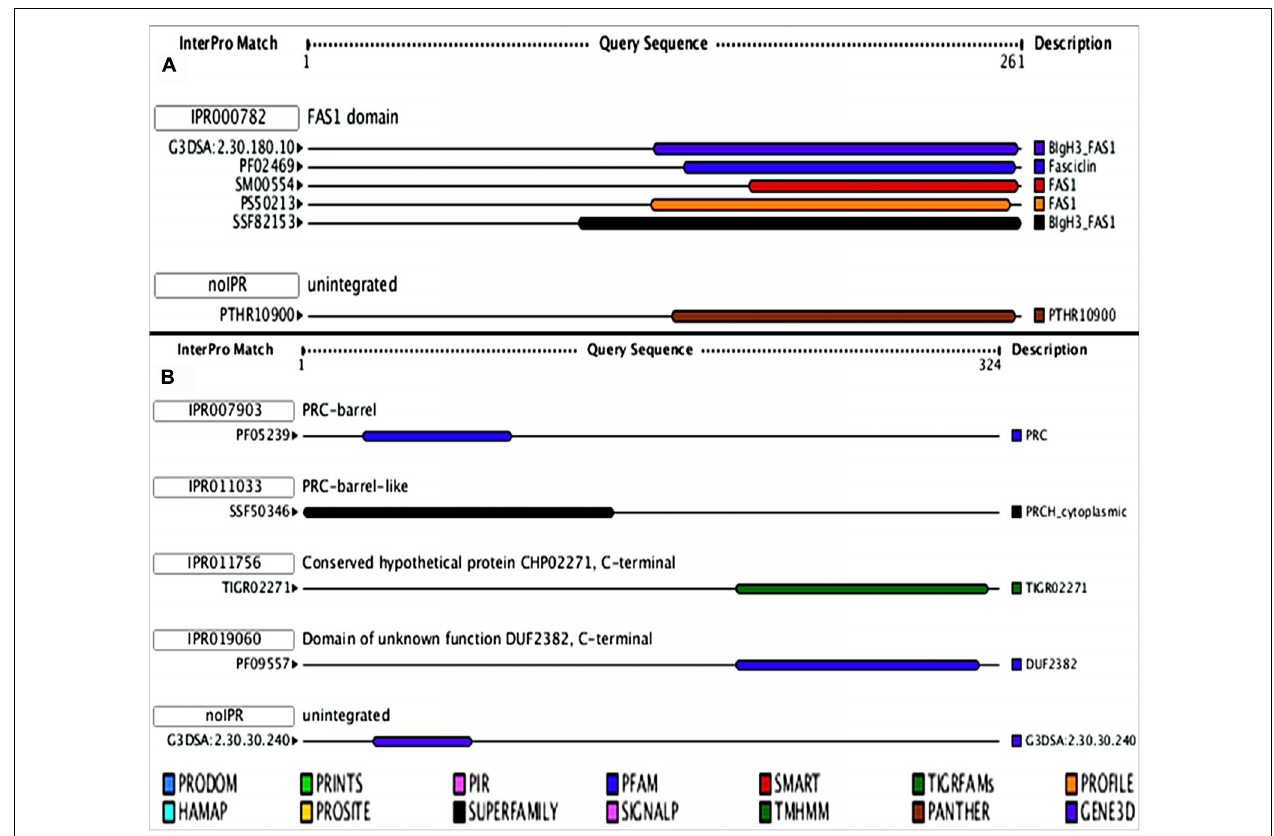
FIGURE 3 | Model showing the functional domains of hypothetical proteins. (A) - all3797, and (B) - all4050 obtained from (http://www.ebi.ac.uk/Tools/pfa/ iprscan/).